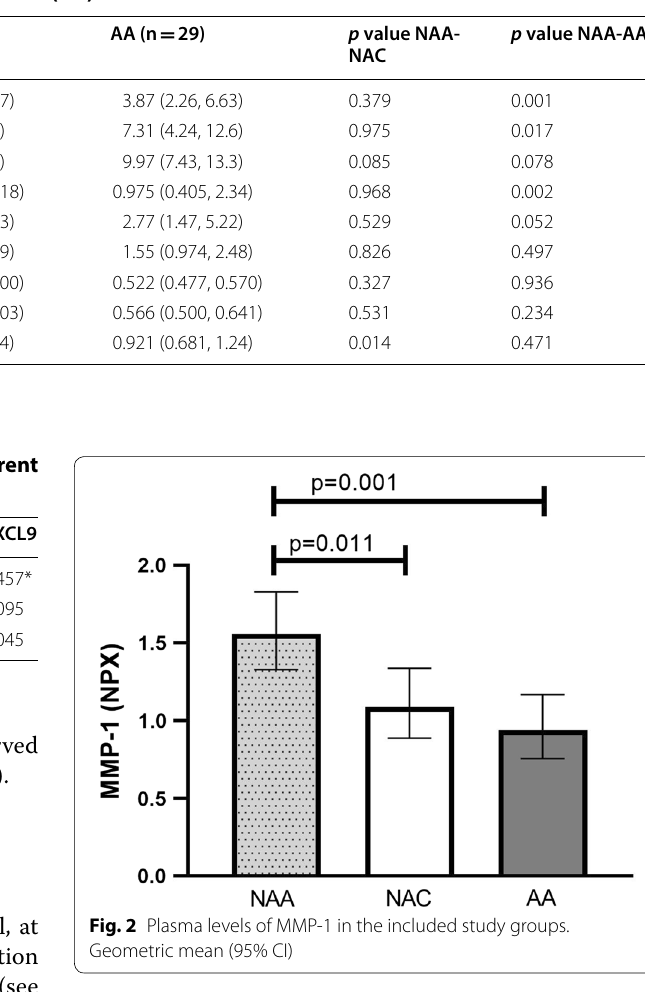
Table 2 IgG and IgA antibody concentrations (mg/L) in the included study groups. Comparisons of non-atopic asthmatics (NAA) with non-atopic controls (NAC) and atopic asthmatics (AA)